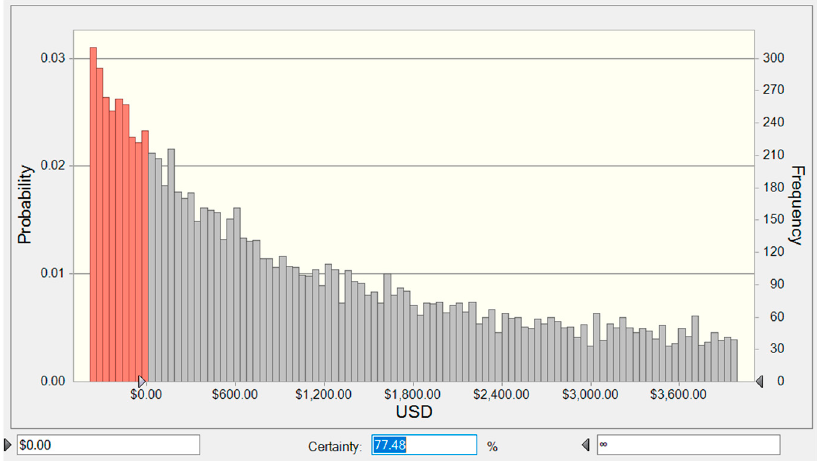
Figure 10. Stochastic results of NPV for a variation of the discount rate in the Brazilian